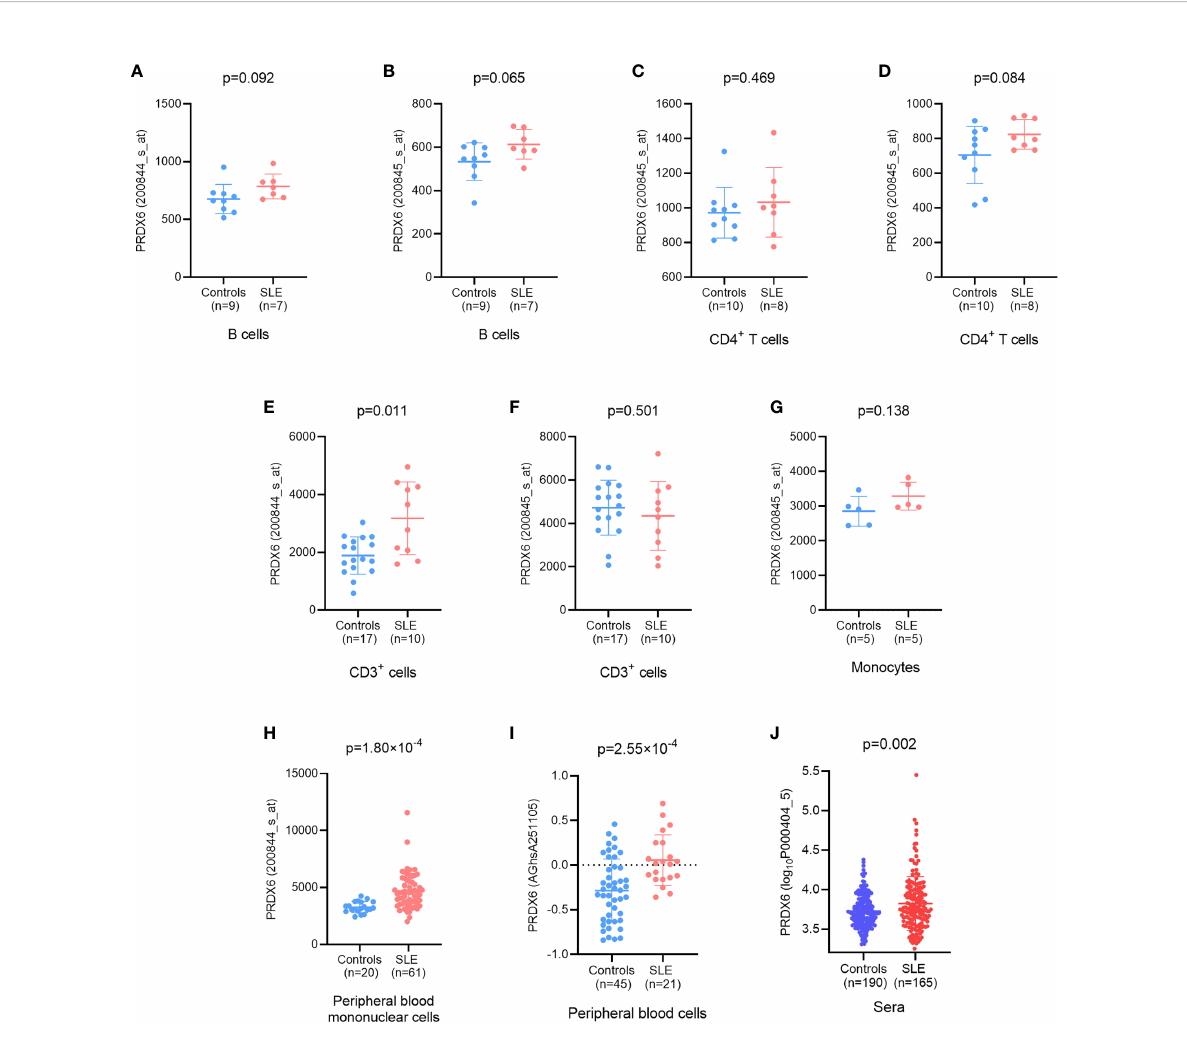
FIGURE 2 Differential expression of PRDX6 between patients with systemic lupus erythematosus (SLE) and controls. (A, B) At the mRNA level, the expression of PRDX6 was elevated in B cells (E-GEOD-4588); (C, D) CD4 + T cells (E-GEOD-4588); (E, F) CD3 + cells (E-GEOD-13887); (G) monocytes (E-GEOD-46907); (H) Peripheral blood mononuclear cells (PBMCs) (E-GEOD-50772); and (I) peripheral blood cells. (J) The level of PRDX6 was also signi fi cantly elevated in patients with SLE compared with healthy donors at protein level (E-MTAB-5900). The analyses were performed based on information available in online databases as